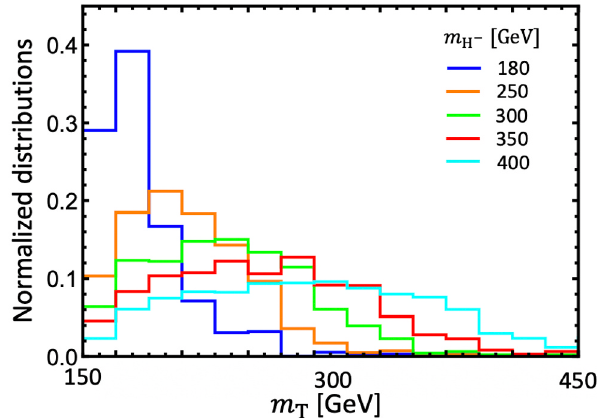
Figure 3 . Normalized signal m T distributions after imposing all kinematic cuts. The different colors correspond to different charged-Higgs masses, as listed in the upper right